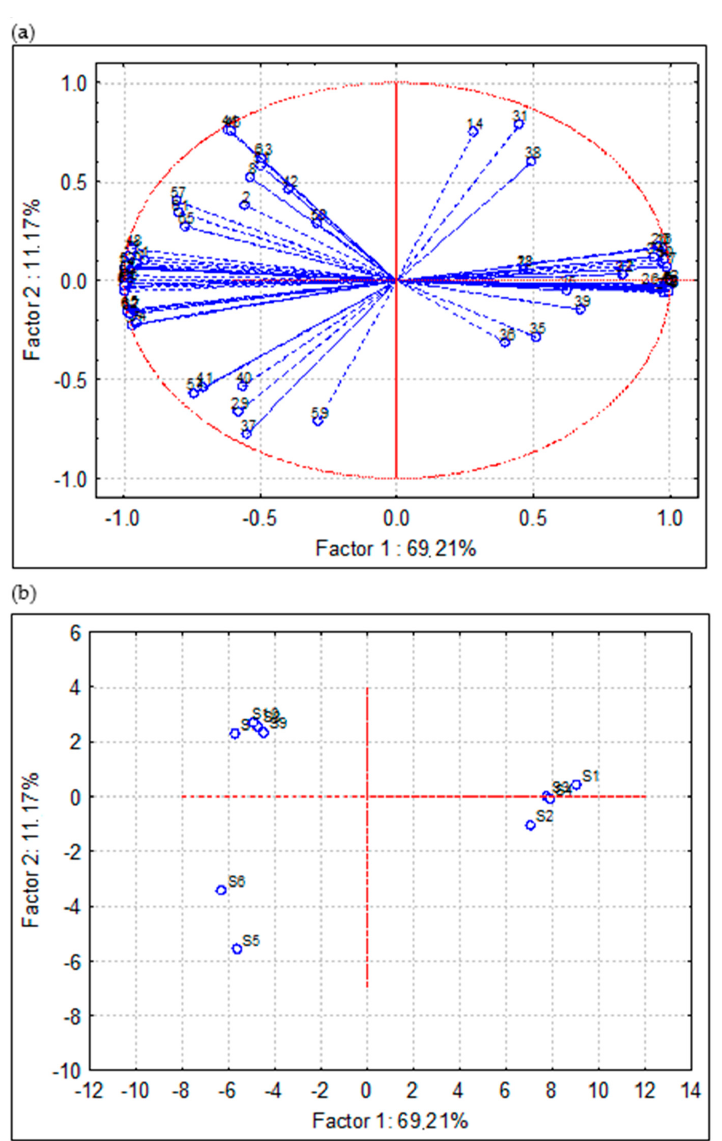
Figure 7. Bi-plot distribution of F1 and F2 by PCA ( a ) variables/scores and ( b ) scores of chamomile extracts and essential oils.